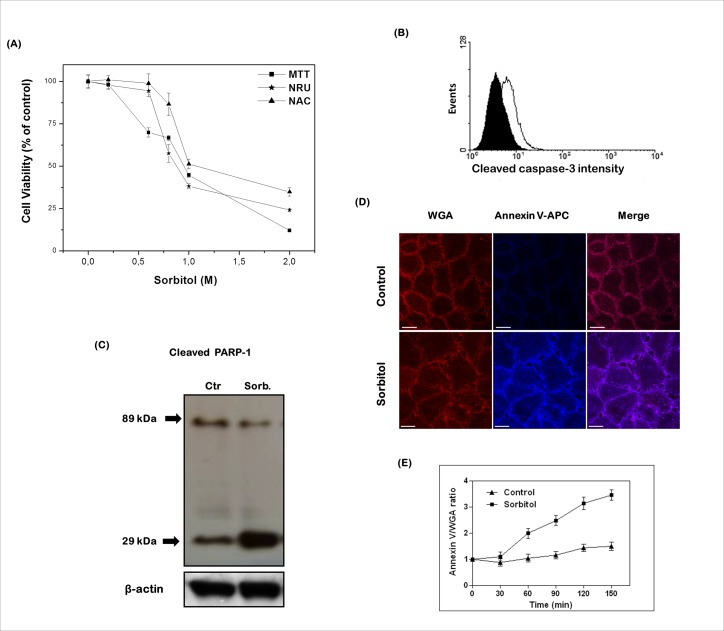
Sorbitol cytotoxicity in HaCaT cells involves induction of apoptosis.
(A) Confluent layers of HaCaT cells were challenged with different concentrations of sorbitol (0.2–2 M in serum-free culture medium) for 2 h, and cellular viability was assessed by three different endpoints assays [MTT reduction (MTT), neutral red uptake (NRU) and nucleic acid content (NAC)]. The results were expressed as percentage of control cell viability (100%) and represented as mean ± SD of three independent experiments run in quadruplicate. HaCaT cells exposed to 1 M sorbitol for 2 h exhibited typical signs of apoptosis. (B) Increased fluorescence intensity of the large fragment (17/19 kDa) of activated caspase-3 detected by flow cytometry in stressed (open histogram) relative to control (black histogram) cells. One representative histogram of three independent experiments for each sample is presented. (C) Increased levels of the small fragment of cleaved PARP-1 by immunoblotting. Equal amounts of total protein (50 μg) from cell lysates were loaded per lane and blotted with specific antibodies. One representative immunoblot of three independent experiments is presented. (D) Increased phosphatidylserine exposition on the extracellular face of the membranes of stressed compared to control cells, as shown by confocal microscopy analysis of membrane labeled with WGA594 (red) and phosphatidylserine exposure labeled with annexin V-APC (blue). Images are representative of three independent experiments at the end of treatment (2 h). Bars = 20 μm. (E) Time-dependent increase in the relative fluorescence intensity of annexin V/WGA was quantified from temporal images captured with intervals of 10 min in experiment depicted in (D), using the Examiner 4.2 software. The results were expressed as mean ± standard deviation of the relative fluorescence intensities of each cell per field of view. At least three different fields were analyzed in three independent experiments.